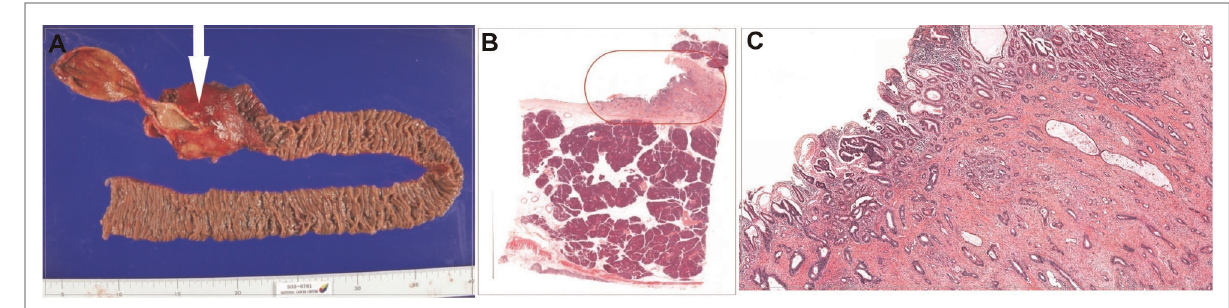
FIGURE 2 ( A ) Gross specimen of pylorus-preserving pancreaticoduodenectomy, with the white arrow indicating cancer. ( B ) Histologic fi ndings of the distal common bile duct. ( C ) Magni fi ed image of the orange closed curve in ( B ), showing moderately differentiated adenocarcinoma cells of the distal common bile